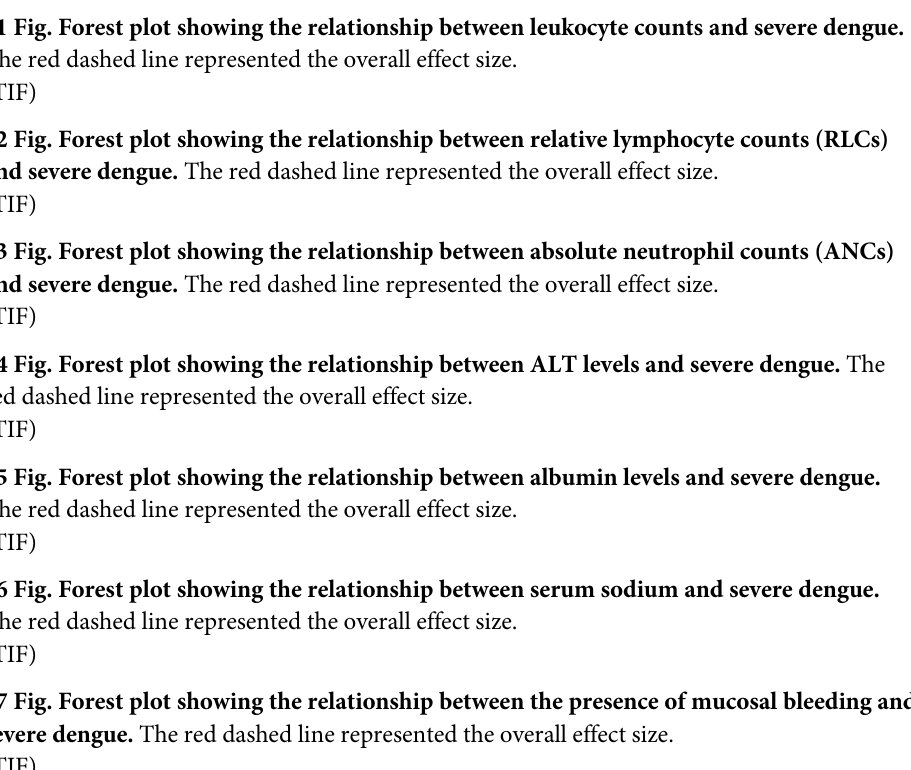
S1 Fig. Forest plot showing the relationship between leukocyte counts and severe dengue. The red dashed line represented the overall effect size. S2 Fig. Forest plot showing the relationship between relative lymphocyte counts (RLCs) and severe dengue. The red dashed line represented the overall effect size. S3 Fig. Forest plot showing the relationship between absolute neutrophil counts (ANCs) and severe dengue. The red dashed line represented the overall effect size. S4 Fig. Forest plot showing the relationship between ALT levels and severe dengue. The red dashed line represented the overall effect size. S5 Fig. Forest plot showing the relationship between albumin levels and severe dengue. The red dashed line represented the overall effect size. S6 Fig. Forest plot showing the relationship between serum sodium and severe dengue. The red dashed line represented the overall effect size. S7 Fig. Forest plot showing the relationship between the presence of mucosal bleeding and severe dengue. The red dashed line represented the overall effect size. S8 Fig. Forest plot showing the relationship between CRP levels and severe dengue. The red dashed line represented the overall effect